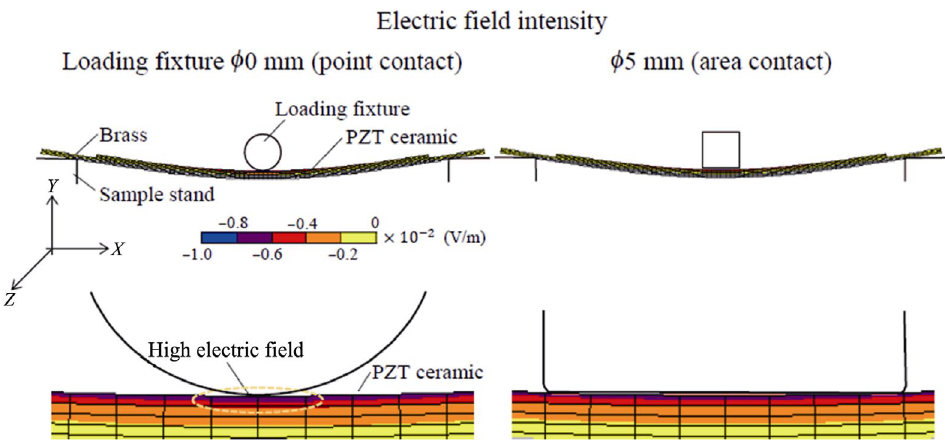
Fig. 11 FE simulation of electric field in the PZT ceramic for loading with ϕ 0 and ϕ 5 mm fixtures.